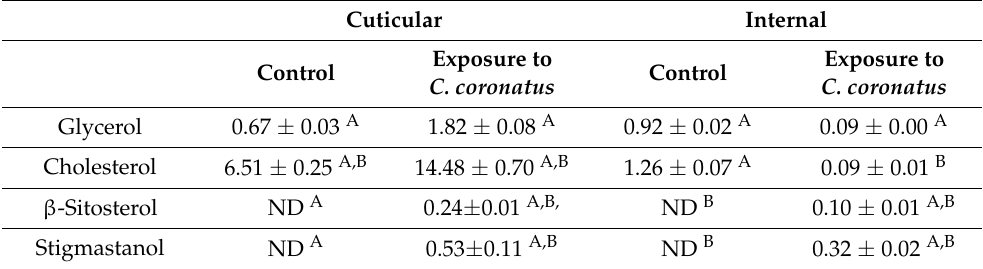
Table 4. Other compounds extracted from Sarcophaga argyrostoma pupae ( µ g/g of insect body ±